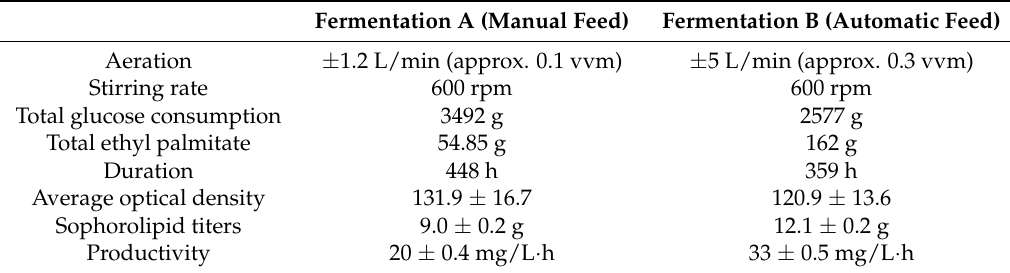
Table 3. Parameters for 30-L fermentations A and B. The average optical density was calculated for the stationary phase.